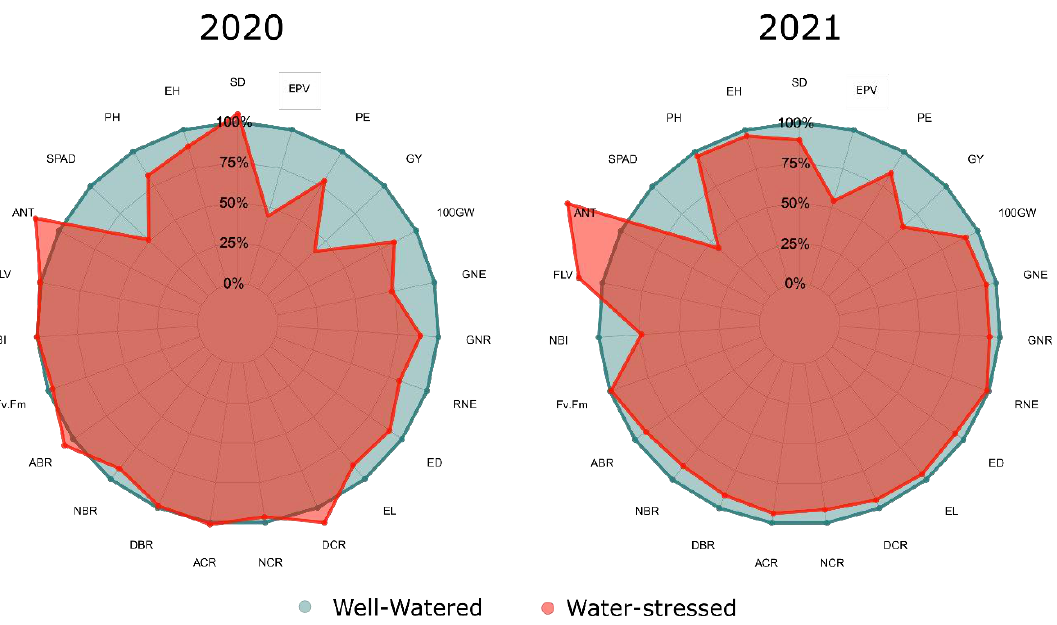
Figure 1. Percentage reduction between the averages of the traits evaluated in the different water conditions — Well-watered (blue) and Water-stressed (red) — in the 2020 and 2021 crop seasons (CS). conditions—Well-watered (blue) and Water-stressed (red)—in the 2020 and 2021 crop seasons (CS). EH — Ear height; PH — Plant height; SD — Stem diameter; EL — Ear length; ED — Ear diameter; RNE — EH—Ear height; PH—Plant height; SD—Stem diameter; EL—Ear length; ED—Ear diameter; RNE— Row number per ear; GNR — Grain number per row; GNE — Grain number per ear; 100 GW — 100- Row number per ear; GNR—Grain number per row; GNE—Grain number per ear; 100 GW—100- grain weight; GY — Grain yield; PE — Popping expansion; EPV — Expanded popcorn volume; SPAD — Relative chlorophyll content; ANT — Relative anthocyanin content; FLA — Relative flavo- grain weight; GY—Grain yield; PE—Popping expansion; EPV—Expanded popcorn volume; SPAD— noid content; NBI — Nitrogen balance index; Fv/Fm — Chlorophyll fluorescence; ABR — Angles of Relative chlorophyll content; ANT—Relative anthocyanin content; FLA—Relative flavonoid content; brace roots; ACR — Angles of crown roots; NBR — Number of brace roots; NCR — Number of crown NBI—Nitrogen balance index; Fv/Fm—Chlorophyll fluorescence; ABR—Angles of brace roots; ACR— roots; DBR — Density of brace roots; DCR — Density of crown roots. Angles of crown roots; NBR—Number of brace roots; NCR—Number of crown roots; DBR—Density of brace roots; DCR—Density of crown